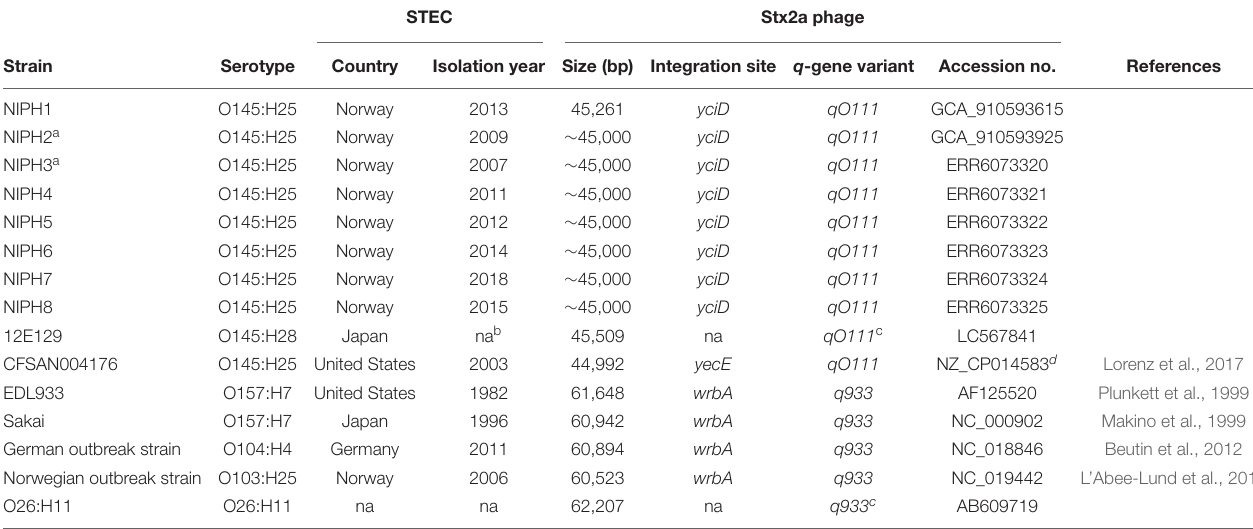
TABLE 1 | Characteristics of Stx2a phages from Shiga toxin-producing E. coli (STEC) of different serotypes examined in this study. STEC Stx2a phage Strain Serotype Country Isolation year Size (bp) Integration site q -gene variant Accession